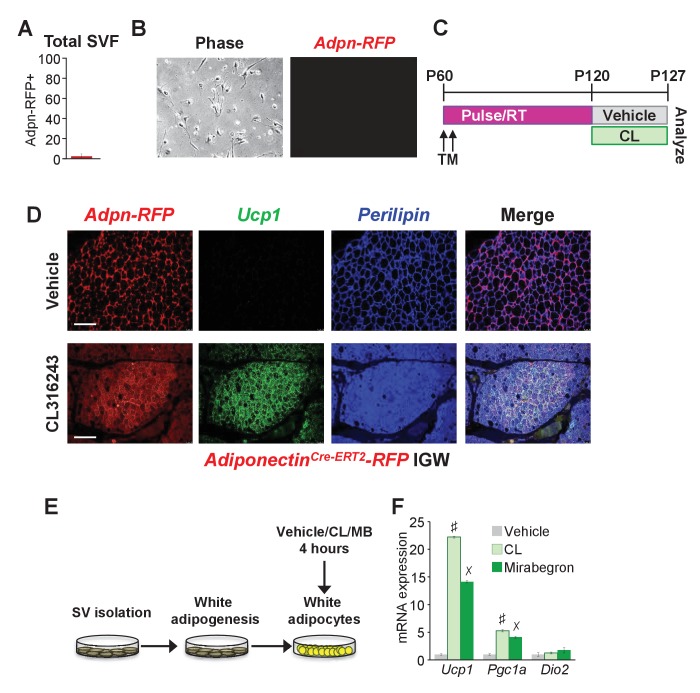
Pre-existing white adipocytes are the major source of Adrb3 induced beiging.(A) FACS analysis from SV cells isolated from TM-induced AdiponectinCre-ERT2; RosaR26RFP (Adpn-RFP) mice (n = 6/group). (B) Representative micrograph and RFP images from SV cells isolated from Adpn-RFP mice and TM induced in culture. (C) Experimental procedure for TM induction and CL treatment of Adpn-RFP pulse-chase experiment. (D) Representative IHC staining of Adpn-RFP fate mapping after 7 days CL treatment. (E) Cell culture experimental procedure. (F) mRNA expression of beige and thermogenic genes from cells described in (E) (n = 4/group in triplicate). ♯p<0.001 CL compared to vehicle-treated cells. ✗p<0.01 unpaired t-test, two tailed: Mirabegron compared to vehicle-treated cells. All data are means ± SEM. Scale bar 100 μm.